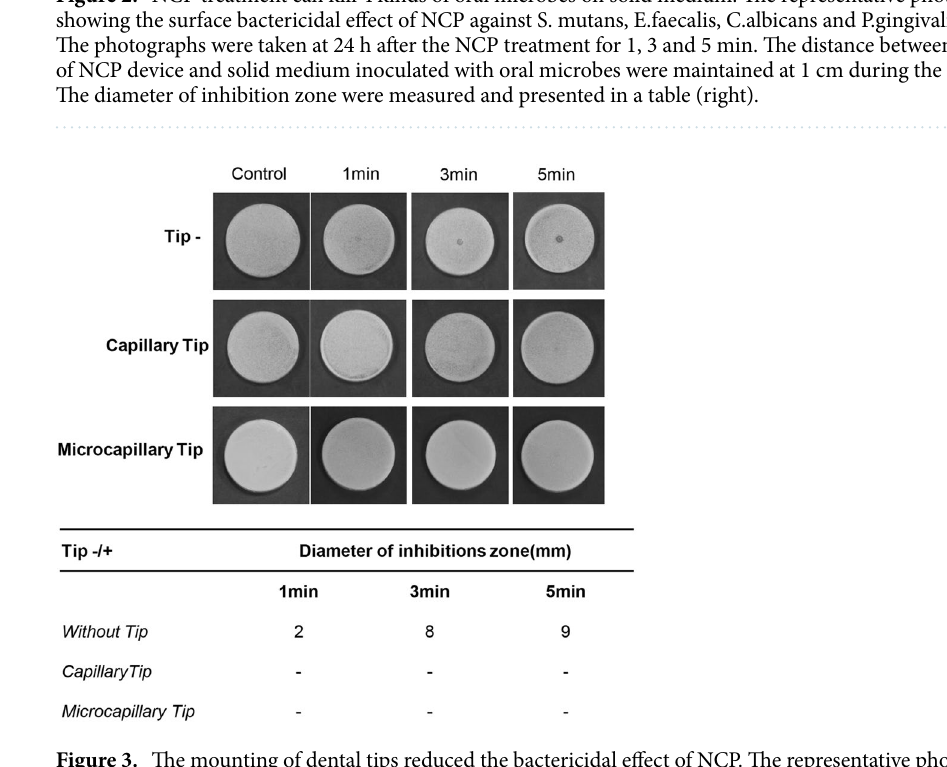
Figure 3. The mounting of dental tips reduced the bactericidal effect of NCP. The representative photographs showing the effect of dental tip (capillary and microcapillary tip) mounting on the bactericidal activity of NCP against C.albicans (upper panel). The photographs were taken at 24 h after the NCP treatment for 1, 3 and 5 min. The distance between the end of NCP outlet and solid medium were maintained at 1 cm during the treatment regardless of dental tip mounting. The diameter of inhibition zone were measured and presented in a table (bottom